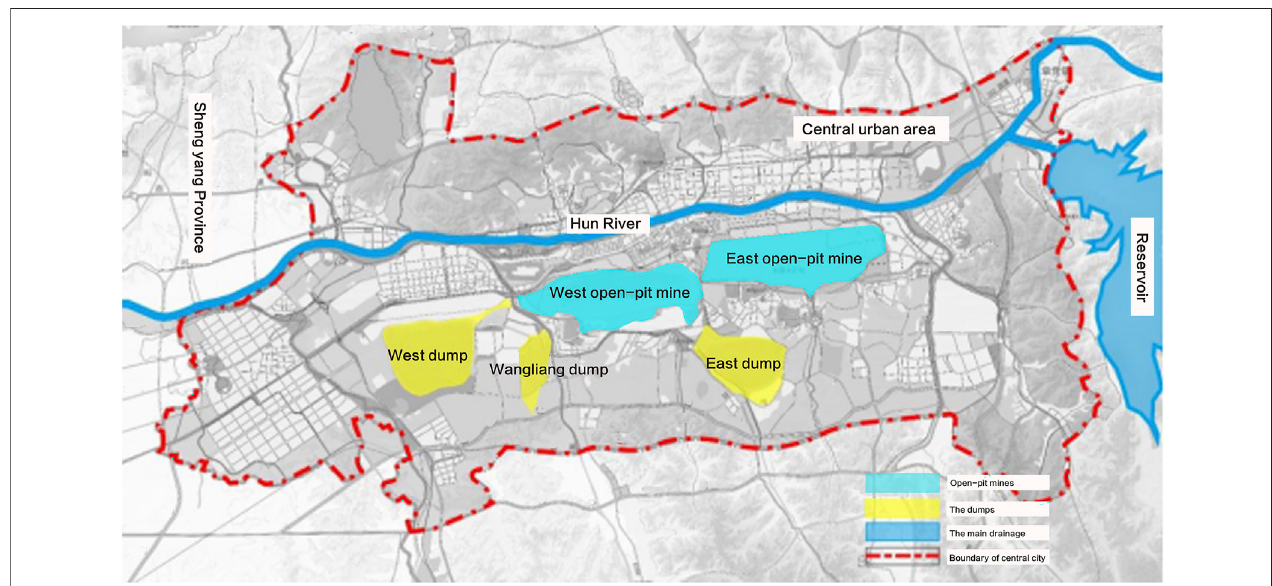
FIGURE 1 | Distribution of abandoned open-pit mines and dump sites in Fushun.